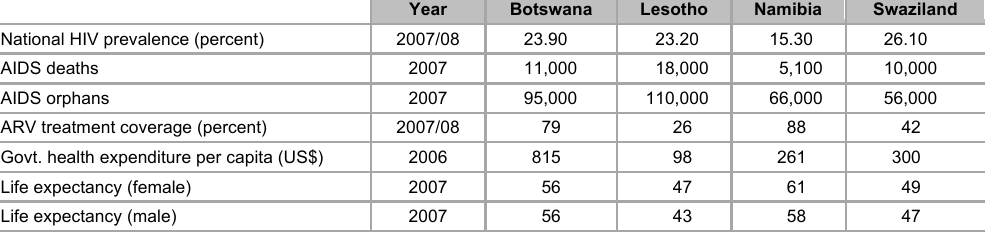
HIV/AIDS in BLNS countries: key